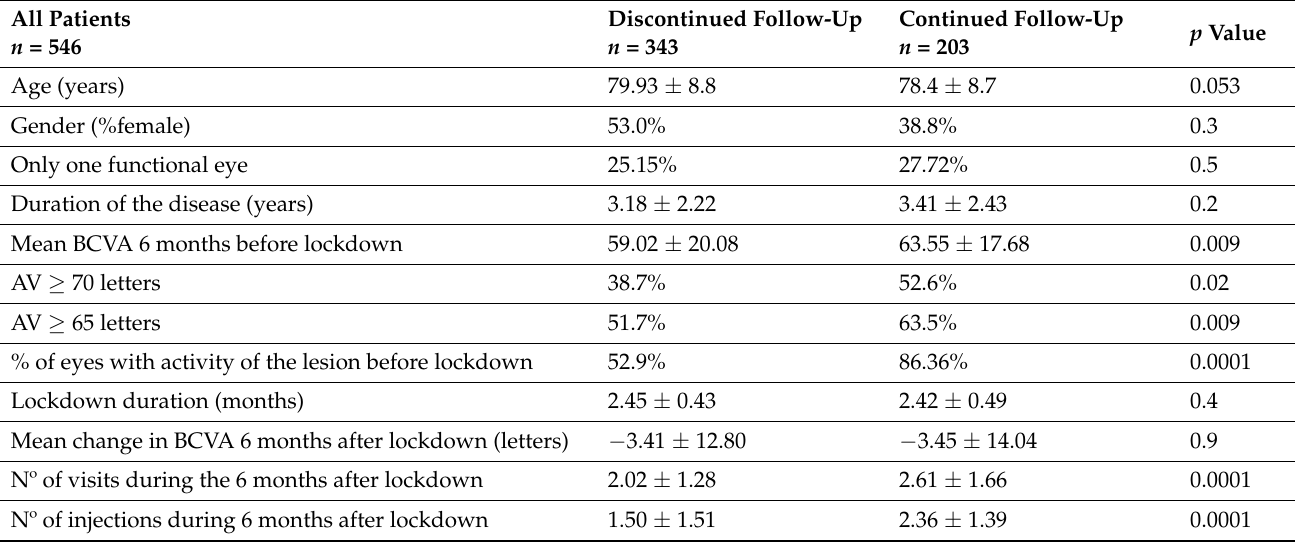
Table 3. Differences between patients that continued on schedule visits and/or IVI treatment and patients that discontinued visits and/or treatment during the